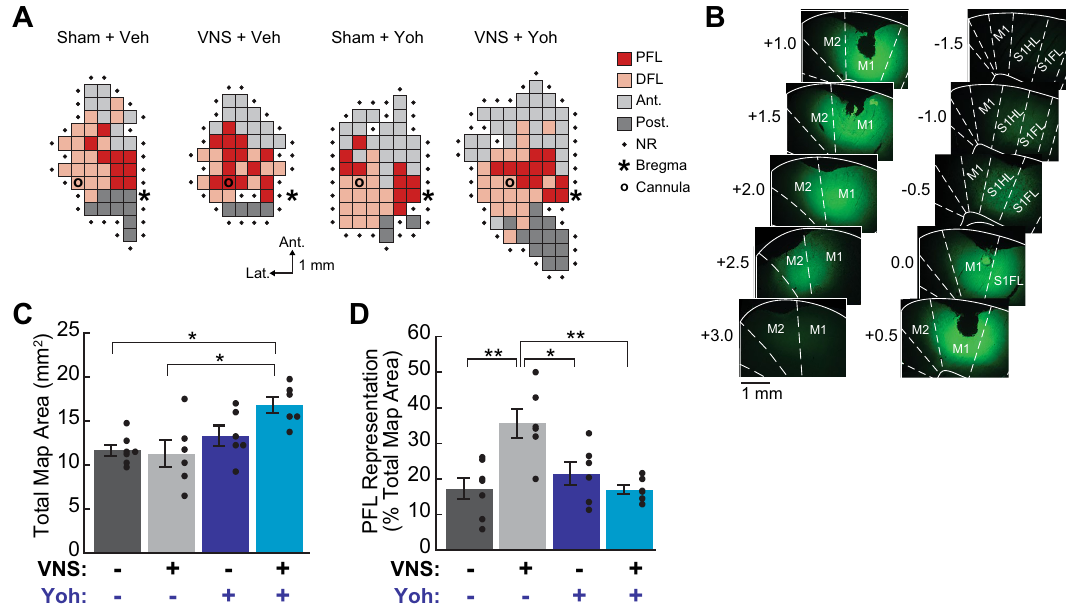
Figure 2. Cortical infusion of selective α2-AR antagonists blocked VNS-induced motor map reorganization. ( A ) Example cortical motor maps from subjects in each treatment group; representative maps are from subjects in each group that exhibited the median total map area and proximal forelimb (PFL) representation for that group. DFL: distal forelimb; Ant.: anterior body representation (vibrissa, head, or neck); Post.: posterior body representation (trunk, hindlimb, or tail); NR: non-responsive. ( B ) Cannula infusion of 1 μL sodium fluorescein dye was used to estimate drug diffusion within the cortex. ( C ) Total motor map area was significantly larger in VNS treated rats that received yohimbine (yoh) infusion compared to other groups. ( D ) To control for variation in total map size across subjects, subregion areas were normalized to total map area for each subject. VNS paired with lever training significantly enlarged the normalized PFL representation in vehicle-infused rats. In yohimbine-infused rats, VNS-driven PFL expansion was blocked. In ( C ), ( D ), filled circles indicate data for individual rats; error bars denote SEM; *p < 0.05, **p < 0.01, Tukey post hoc